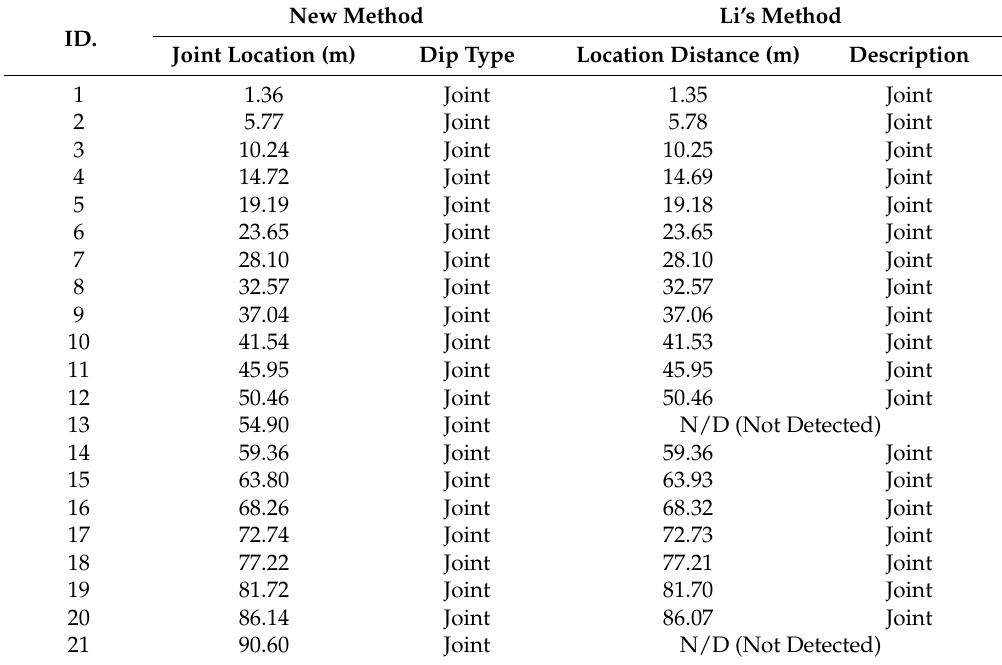
Table 3. Joint Identification and Location with Two Different